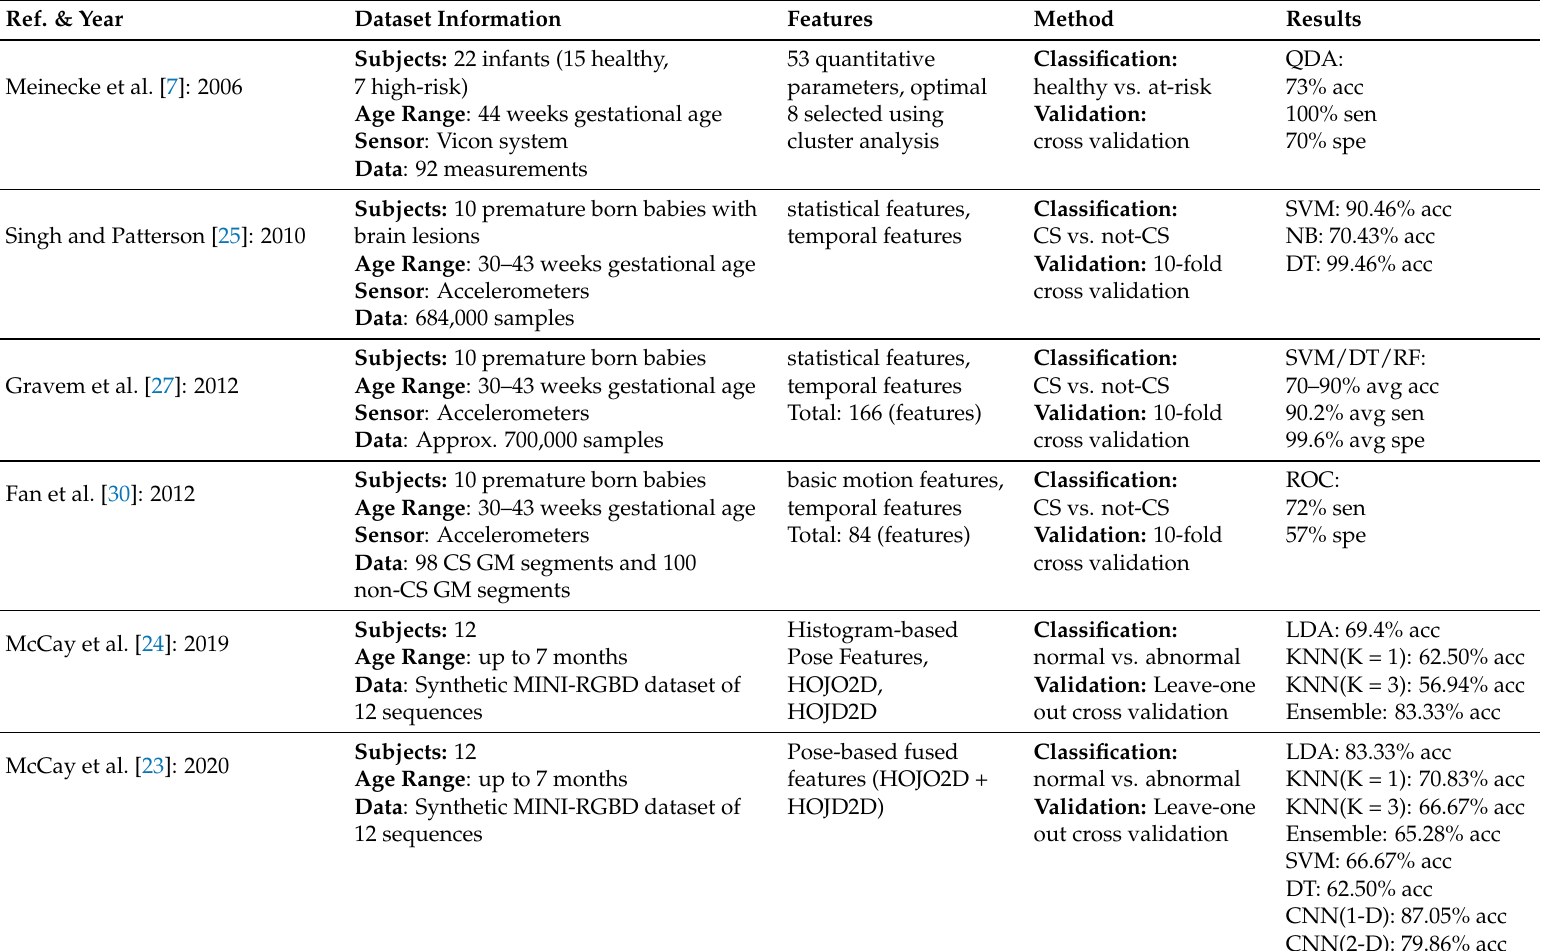
Table 4. Classification results of general movements (GMs)